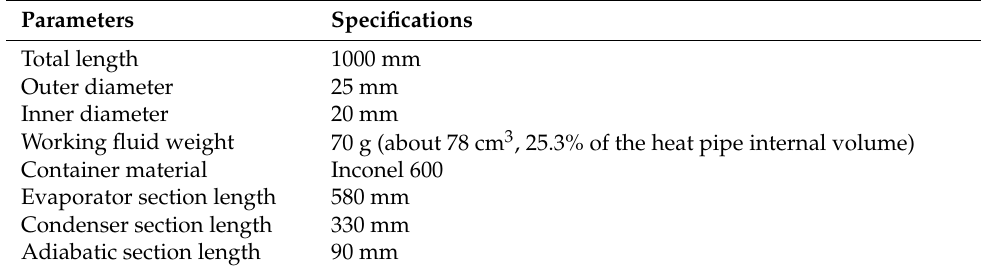
Table 2. Parameters of the Na-K alloy heat